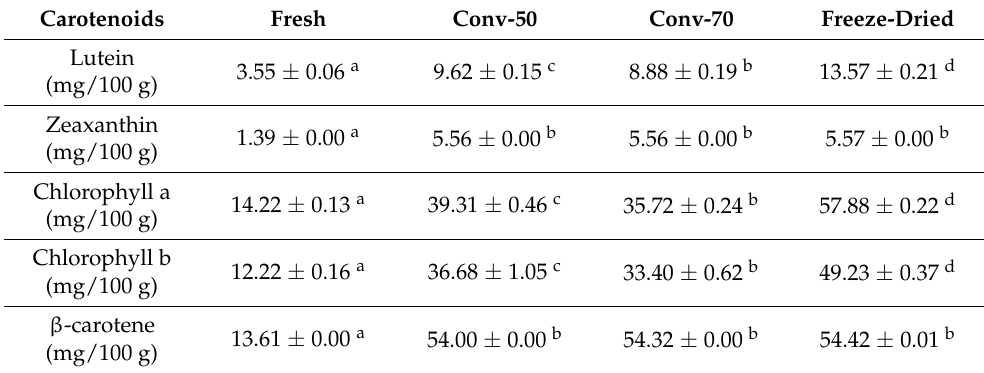
Table 3. The content of selected carotenoids in fresh and dried quince. Carotenoids